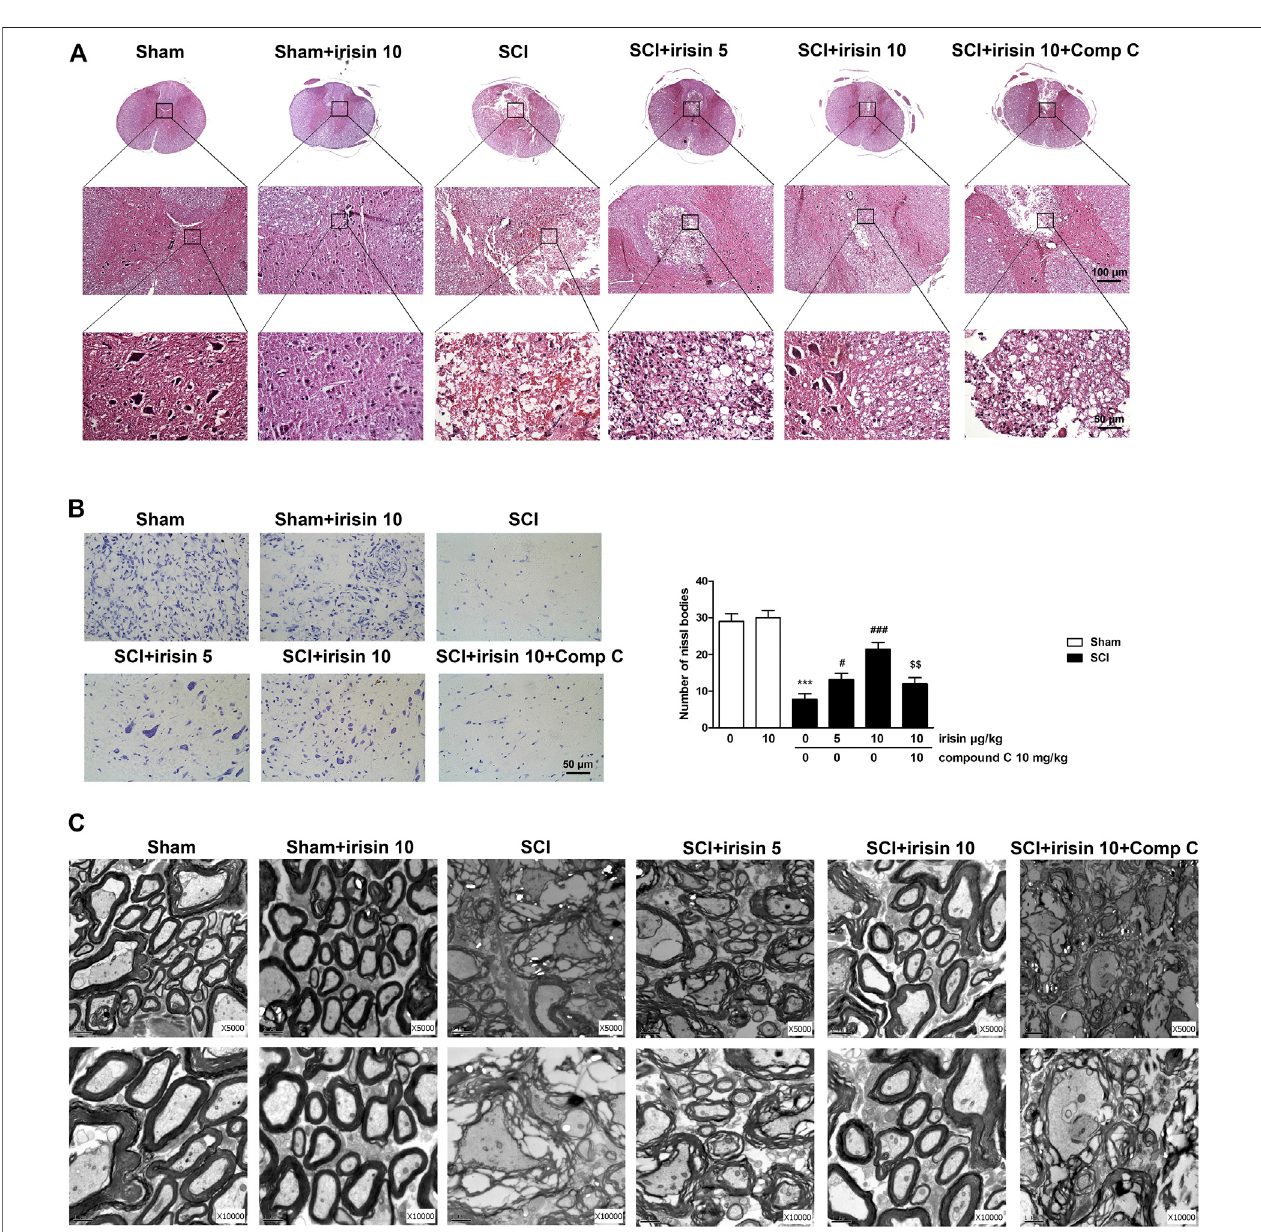
FIGURE2|(A) HEstainingon transverse section ofspinalcord at T9in shamand spinalcord injury (SCI)rats atthe28th dayafter spinal cord injury(The fi rst rowis × 50, second is × 200 and third is × 400); (B) Nissl staining ( × 40) on transverse section at T9 in rats of sham and SCI, and quantitative analysis of Nissl bodies in staining images(n (cid:2) 4),scalebar (cid:2) 50 μ m.SCIsurgerydecreasedNisslbodiesonday28( p (cid:2) 0.00009),andirisintreatmentimprovedthisdecrease( p (cid:2) 0.00021in10 μ g/kgirisin group). Irisin ’ s function were reversed by compound C treatment ( p (cid:2) 0.0039). (C) Ultrastructural morphology of myelin sheath and neuronal cells in the dorsal column and epicenter surrounding gray matter of different groups. Micrographs represent samples taken from two rats in each group. Data are presented as Mean